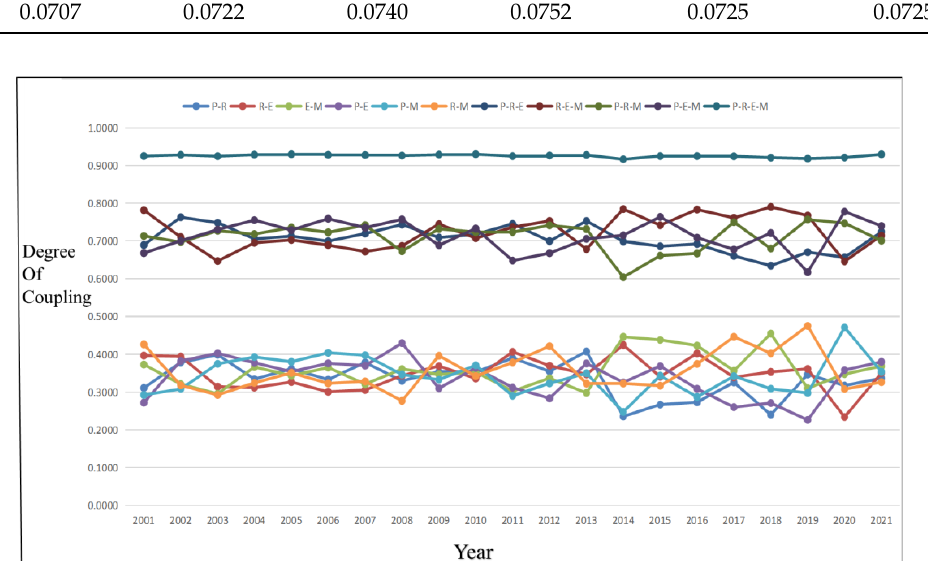
Figure 5. Visualization of coupling degree calculation results. Table 6. The comprehensive coordination index